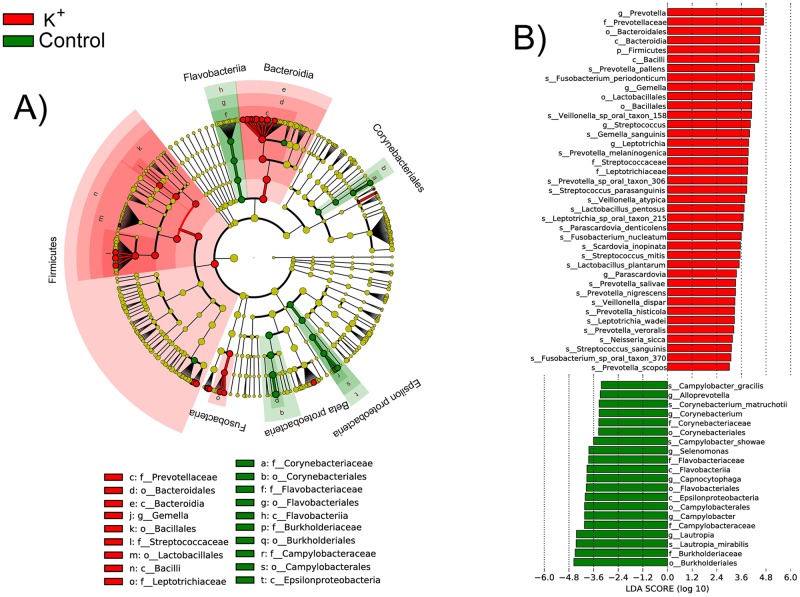
Statistical differences in metatranscriptome composition after addition of ion potassium.Phylogenetic assignment of the mRNA hits was performed using Kraken [17] and were analyzed using LEfSe with default parameters (p-value < 0.05 for Kruskal-Wallis rank sum test on classes and pairwise Wilcoxon test between subclasses of different classes) to identify significant differences in transcription activity at species level between the microbial communities compared. A) Cladogram showing the taxonomic distribution of lineages whose expression levels had a LDA value of 3.0 or higher as determined by LEfSe [18]. B) Histogram of LDA scores for differentially active taxa. In red are taxa whose activity, as determined by number of transcripts, was increased in the presence of K+. In green are species whose activity was higher in the absence of K+.